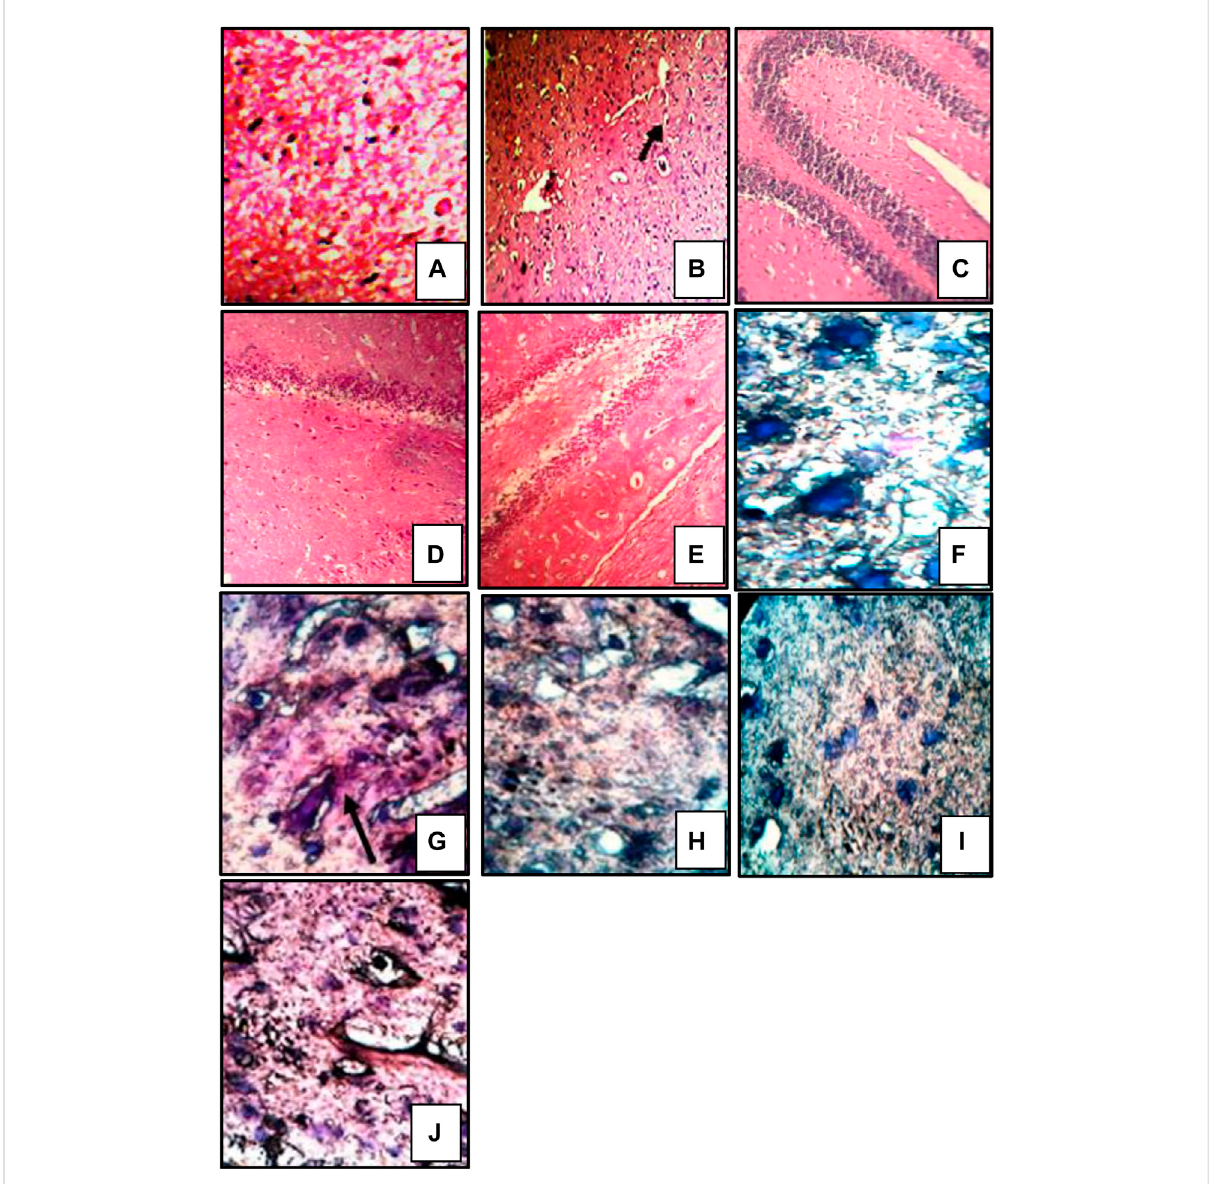
FIGURE 9 Histological sections of the brain were stained with HE staining, magni fi cation 400 × (A – E) , and congo red staining, magni fi cation 1,000 x; oil immersion (I,J) (Sodhi and Singh, 2014). “ Control (A) shows normal histological features. SA-treated rat (B) showed focal as well as diffuse severe neutrophilic in fi ltration, congestion of blood vessels, and pericellular edema. Bergenin administered (30 and 60 mg/kg) SA-treated rats (C,D) respectivelyfeaturingmildneutrophilicin fi ltrationandpericellularedema.BADGEadministration(30 mg/kg)alongwithbergenin(30 mg/kg)to SA-treated rats (E) showed focal as well as diffuse severe neutrophilic in fi ltration. Control (F) congo red deposition was not detected. SA-treated rat (G) showingorange-reddepositsofcongored.Bergeninadministered(30and60 mg/kg)SA-treatedrats (H,I) respectivelyshowedsigni fi cantcongo red deposits. BADGE administration (30 mg/kg) along with bergenin (30 mg/kg) to SA-treated rats (J) showing orange-red deposits of congo red.